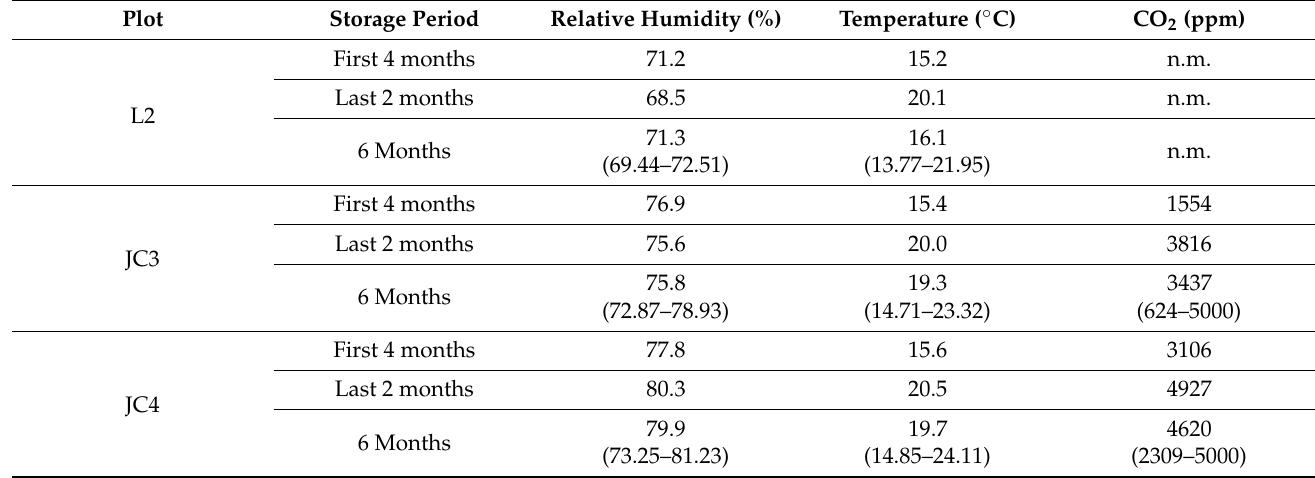
Table 2. Relative humidity, temperature, and CO 2 means and ranges of the barrels of each maize stored plot (L2, JC3, and JC4) (n.m., not